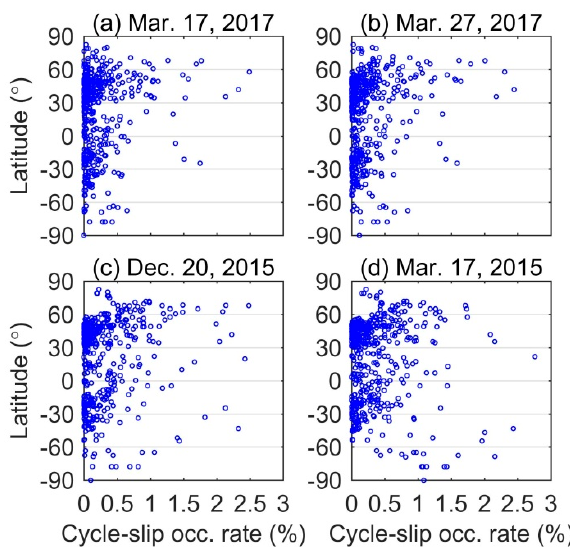
Figure 11. Distribution of cycle-slip occurrence rate against geomagnetic latitude for all IGS stations statistics on: ( a ) 17 March 2017 as the quiet day reference; ( b ) 27 March 2017 as the moderate storm; ( c ) 20 December 2015 as the intense storm; and ( d ) 17 March 2015 as the super storm, respectively.